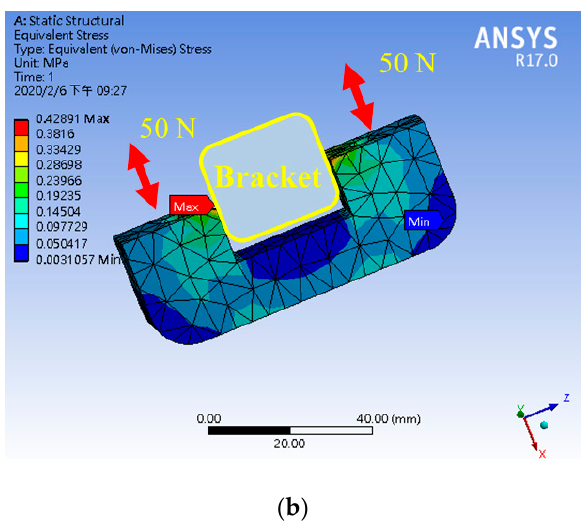
Figure 6. ( a ) Motor mount vs. stress for the steer-by-wire system; ( b ) bracket vs. stress for the steer-by-wire system.